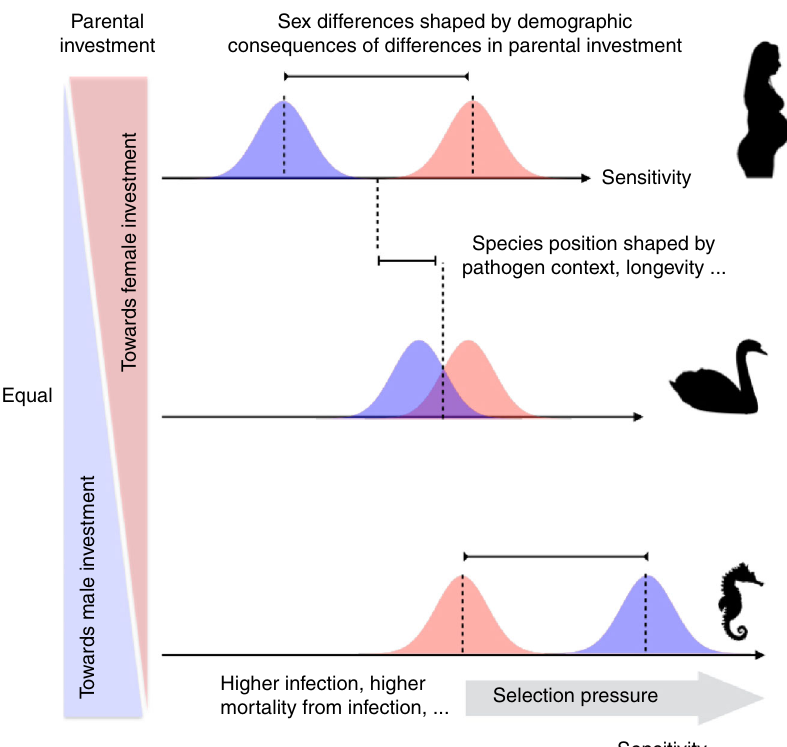
Fig. 5 Predicted relationships between parental investment and the evolution of sensitivity: increased parental investment of females (moving from center up) or males (moving from center down) will amplify features that select for increased sensitivity ( x axis), such as increased infection during reproductive years, increased mortality during infection, or increased mortality during reproductive years coupled with high early infection. In species where both sexes make similar investments (e.g., swans, middle) immune sensitivity should be similar (overlapping distributions, center); for species where females make larger investments in parenting (e.g., mammals like humans, top) sensitivity should be higher in females, and conversely for species where the reverse is true (e.g., seahorses, bottom). Co-evolution between parental investment and sexual selection will shape evolution of features that further modulate this: in mating systems where older males dominate reproduction (polygyny), male sensitivity should be further reduced relative to females given concentration of infection at young ages. These predictions are, in principle, testable across such life history diversity: sensitivity could be estimated in terms of the pathogen dose-dependence of immune cell activation (in vitro if not in vivo), where cells of relatively sensitive hosts should activate at lower pathogen doses than cells of relatively insensitive hosts of changes in underlying parameters on the population rate of increase Table 2 Possible mortality hazard scenarios for an individual (confusingly called “ sensitivity ” ): of age x Respond Don ’ t respond μ − s “ false Infected ( i x ) μ id × s e ( “ true d × (1 e ) ( positive ” ) negative ” ) 0 ( “ true negative ” ) Mortalityhazards occuraccordingto the probabilityof being infectedat age x , i x , combinedwith the probabilities de fi ned by the discrimination trade-off (sensitivity/speci fi city or s e / s p ) outcome. The parameter μ i captures the mortality hazard associated with exuberant immune reactionsintheabsenceofinfection(falsepositives),theparameter μ id capturesthesamebutin the presence of infection, and μ d captures the mortality hazard associated with undetected infections (false